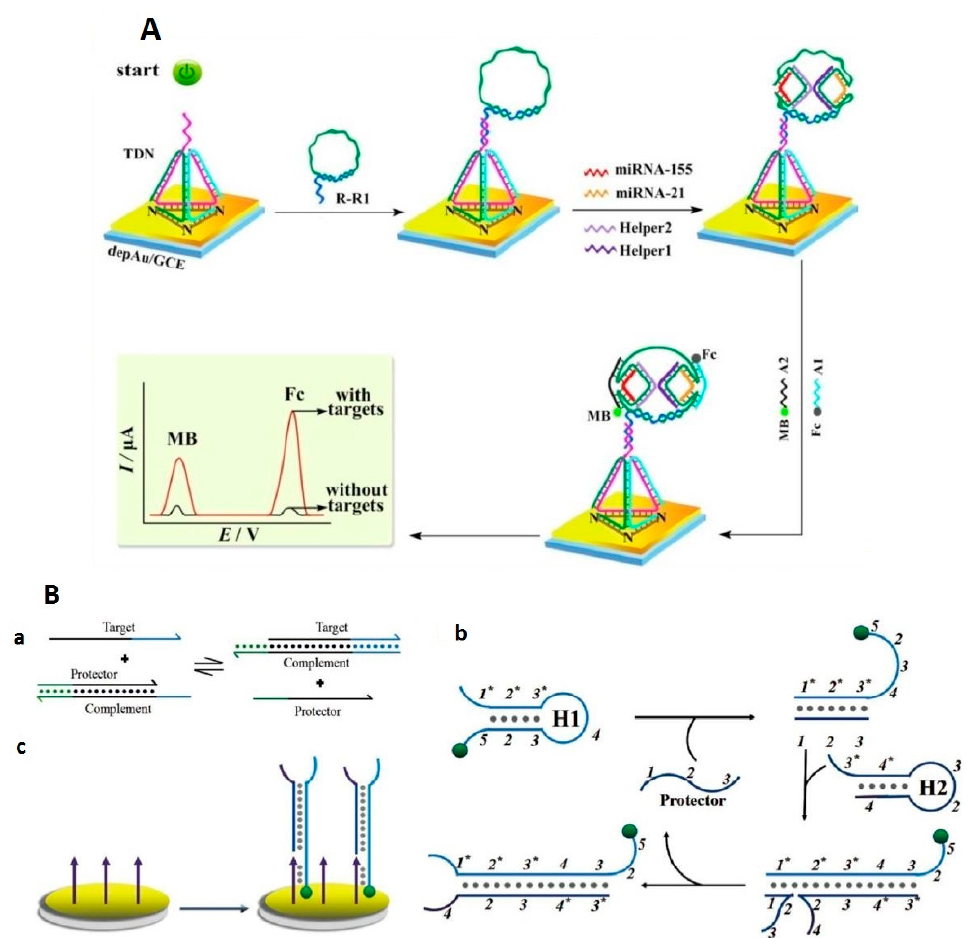
Figure 3. Example of the biosensor with an electrochemical response based on “signal ON”, ( A ) detection approach using DNA circle for simultaneous detection of miRNA (reproduced with permission from the publisher [60]; ( B ) scheme of the biosensor design using stand displacement reaction and catalytic hairpin assembly (reproduced with permission of Royal Society of Chemistry) [61].